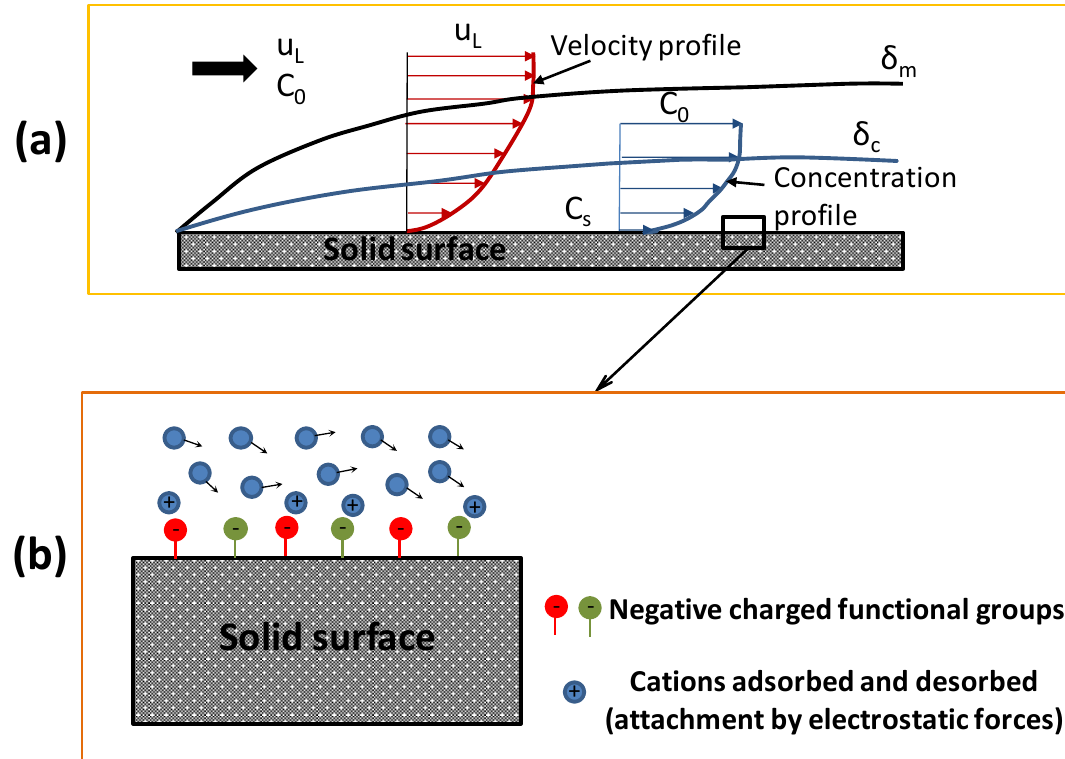
Figure 7. ( a ) Approximate velocity and concentration boundary layers at the vicinity of the grain surface (its curvature is ignored; u L is the local pore velocity; C s is the solute concentration at the liquid/solid interface). ( b ) At the submicroscopic level, the sorption of a cationic dye on the solid surface may be governed by the near-surface concentration of MB cations, the frequency of their collisions with the surface, and the strength of attractive electrostatic forces between the negatively charged sites and positively charged cations.